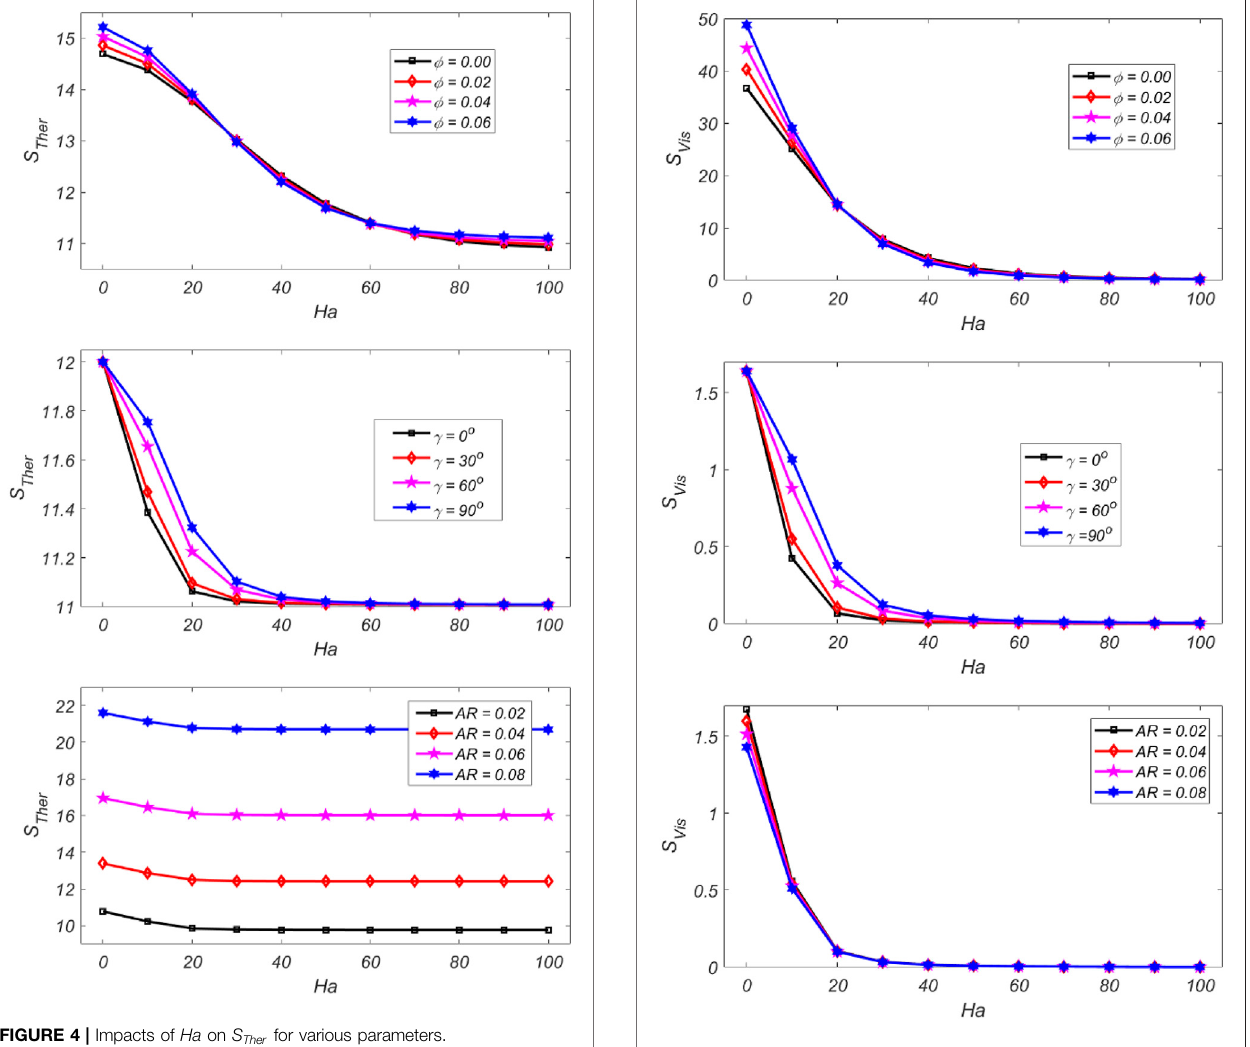
FIGURE 5 | Impacts of Ha on S Vis for various